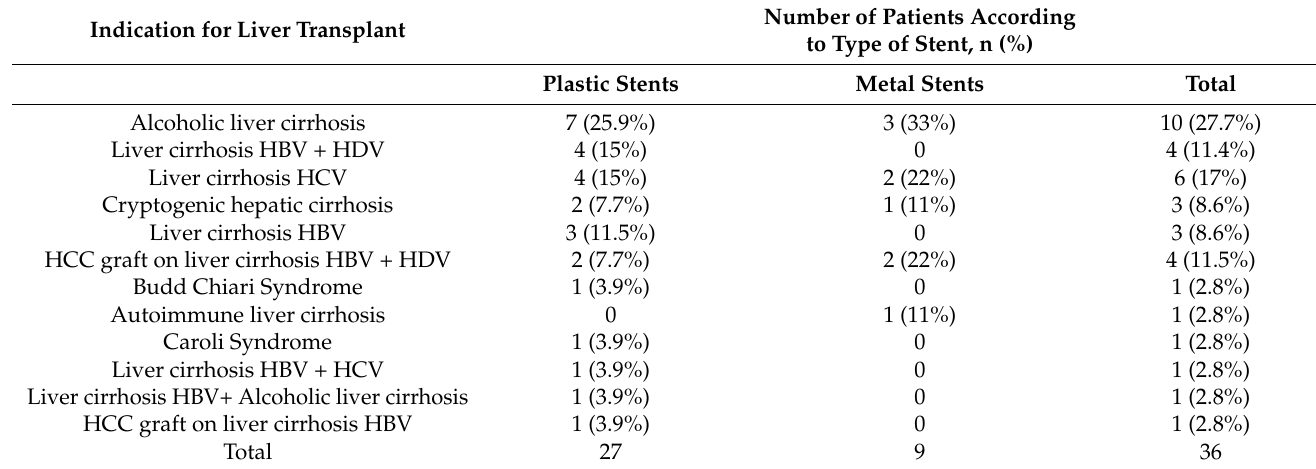
Table 2. The patients’ indication for liver transplant and the stents used.